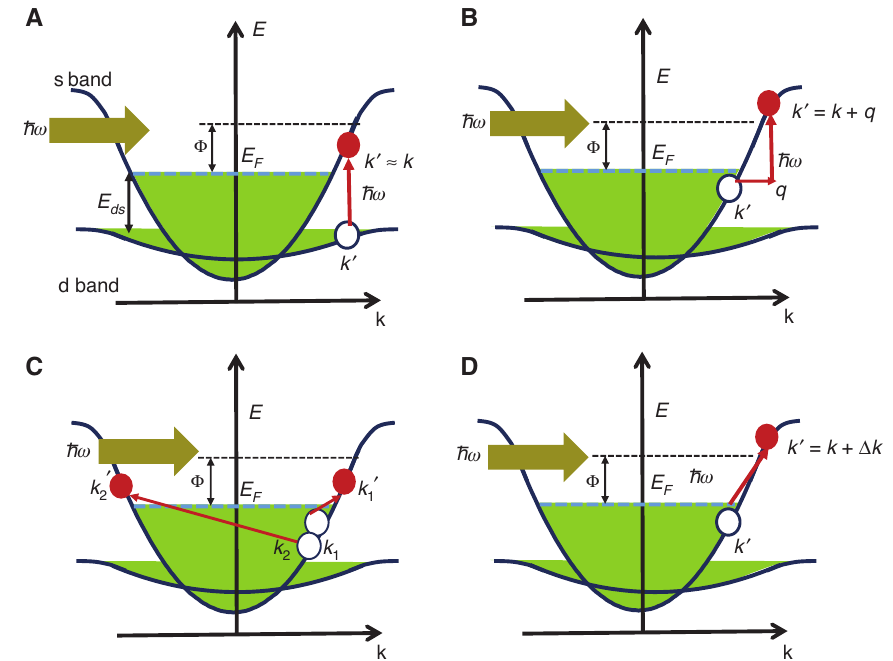
Figure 3: Four mechanisms of electron-hole pair generation in metals where the average kinetic energy of electrons and holes is low. (A) direct “vertical” interband transition; (B) phonon (or impurity)-assisted transition where the average energy of electrons or holes is ħ ω /2; (C) EE Umklapp scattering-assisted transition with two electron-hole pairs generated for each SPP and their average kinetic energies being ħ ω /4. (D) Landau damping or surface collision-assisted “tilted” transition where the average energy of electrons or holes is ħ ω /2. As one can see, the carriers generated via processes (B) and (D) are far more likely to have energy sufficient to overcome the surface (Schottky) barrier Φ and be injected into the adjacent semiconductor or dielectric.